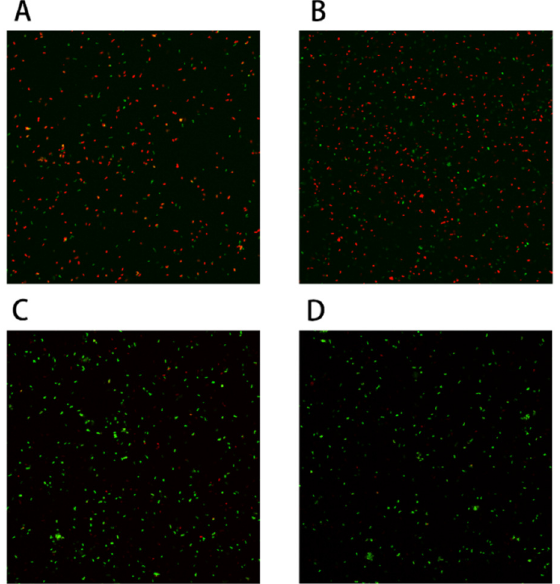
Figure 6. Bifidobacterium longum CCFM 1029 cell membrane integrity test: ( A , B ) are control groups without proline; ( C , D ) are experimental groups with proline.